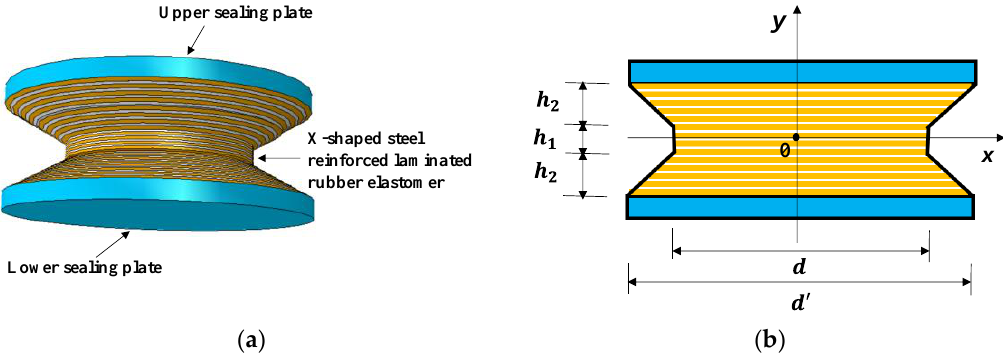
Figure 1. ( a ) Three-dimensional appearance of XRB; ( b ) longitudinal section of XRB. Under horizontal seismic load, shear deformation occurs in the seismic isolation